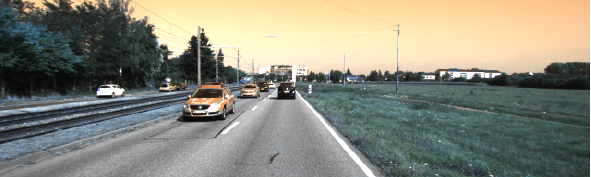
Figure 9. Model—ResNet18, layer 7, total channels—64, layer type—Max Pooling. ( a ) Output of channel 0. ( b ) Output of channel 5. ( c ) Output of channel 33. ( d ) Output of channel 63.